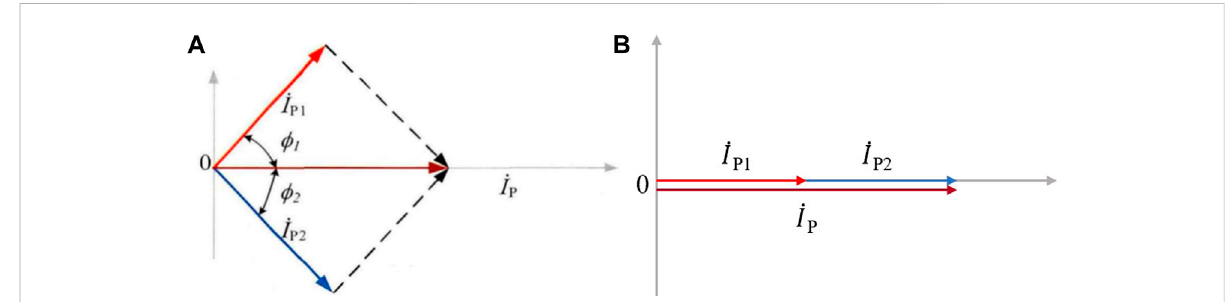
FIGURE 6 Current vector diagrams. (A) The currents are not synchronized. (B) The currents are synchronized.